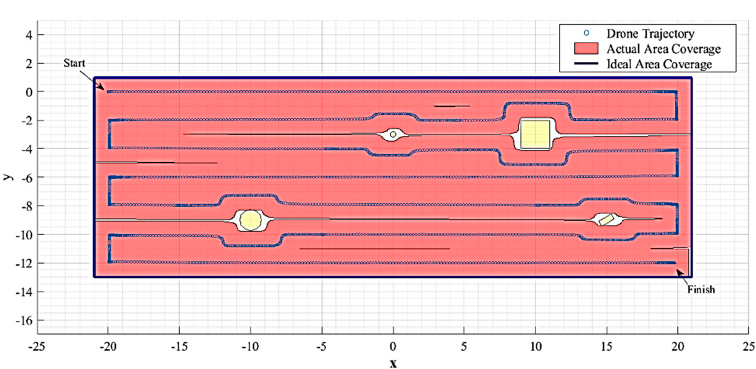
Figure 15. Spray coverage in 2-m path gap mission with 10% liquid load.